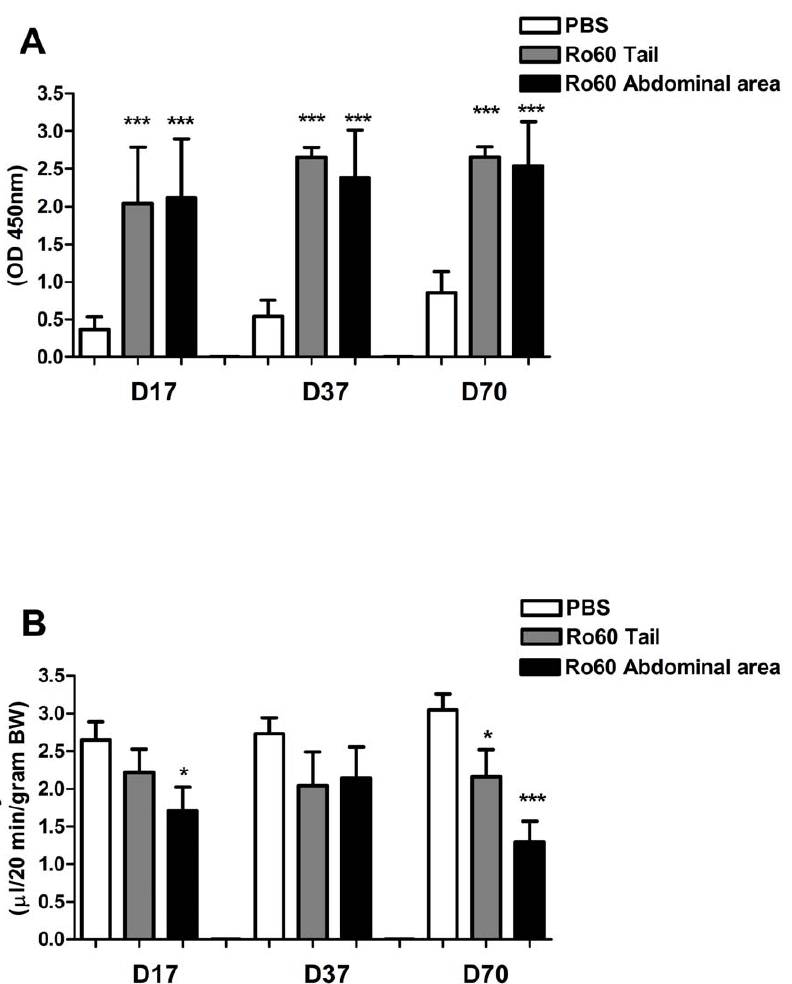
Figure 1. Increased anti-Ro60 antibodies and salivary gland dysfunction in Ro60-immunized Balb/c. Balb/c mice were immunized with Ro60 peptide or PBS (mock) in the tailbase or the abdominal area. Plasma from all animals were analyzed at the indicated time points for anti-MAP- Ro60 antibodies ( A ). The same mice were analyzed for pilocarpine stimulated salivary flow ( B ). Data shown are mean values + /- SEM for 10 mice/ group. Significant differences are indicated (*** p , 0.0001; * p , 0.05) and were determined by unpaired Student’s t-test. D: number of days post primary injection.